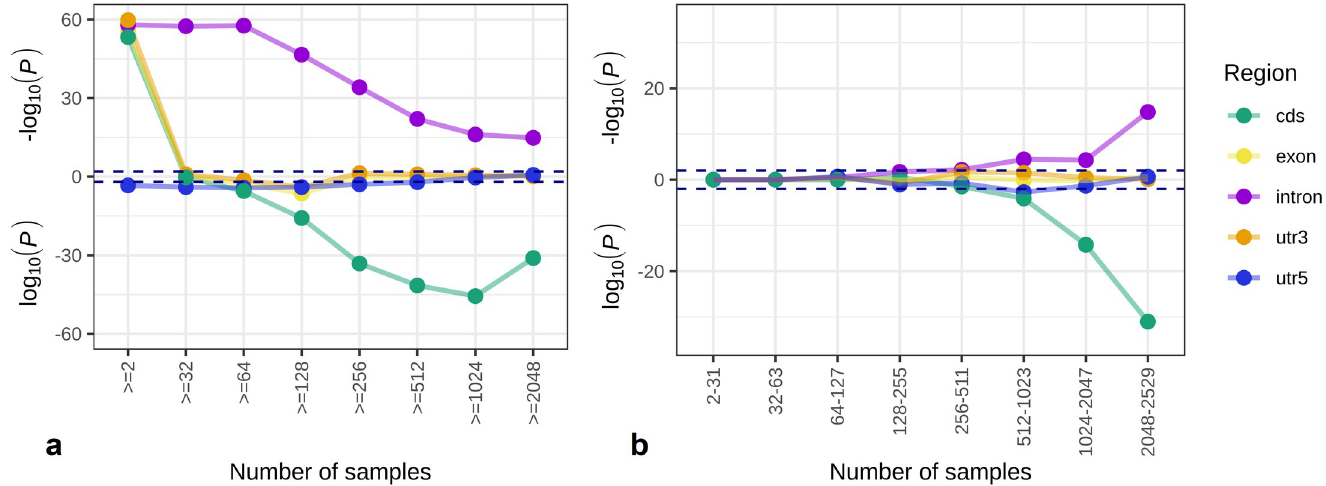
Fig 3. Enrichment analysis of EBML with respect to gene regions: Introns, exons, coding sequences, and UTRs. Analysis of microsatellites draws upon whole exome sequenced samples from the 1000 Genomes Project; consequently, enrichment with respect to gene regions could not be checked by directly comparing all 316,147 tested microsatellites to the 3,984 EBML. Instead, two series of enrichment tests are performed on subsets of the tested and EBML. a, In the first series, each iteration removes microsatellites based on the minimum number of available samples. b, In the second series, each iteration considers microsatellites within a range of available samples. Each point represents a χ 2 test of the null: no association between EBML and the gene region. Over represented regions are plotted as -log(p) and appear above the x-axis; under represented regions are plotted as log(p) and appear below the x axis. Statistical significance (p = .05) is indicated with a dashed line. The null is rejected for intronic microsatellites (over-represented) and coding microsatellites (under-represented). The same conclusion is reached in both panels suggesting the results are robust to details of the analysis. Note: exonic microsatellites include CDS and UTR microsatellites based on an independent series.